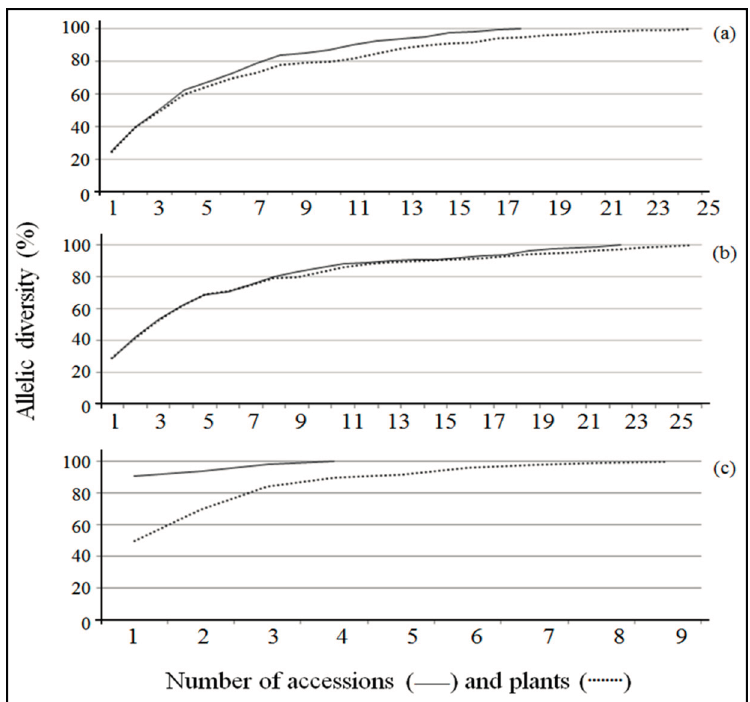
Figure 5. Allelic diversity as a function of the number of plants included in the